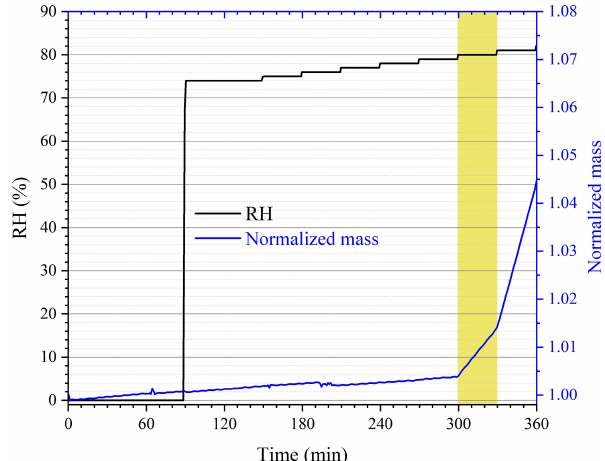
Figure 3. Typical experimental data in determination of DRH at a given temperature by stepwise increasing RH. The experiment dis- played in this figure was conducted to measure DRH of ( NH 4 ) 2 SO 4 at 25 ◦